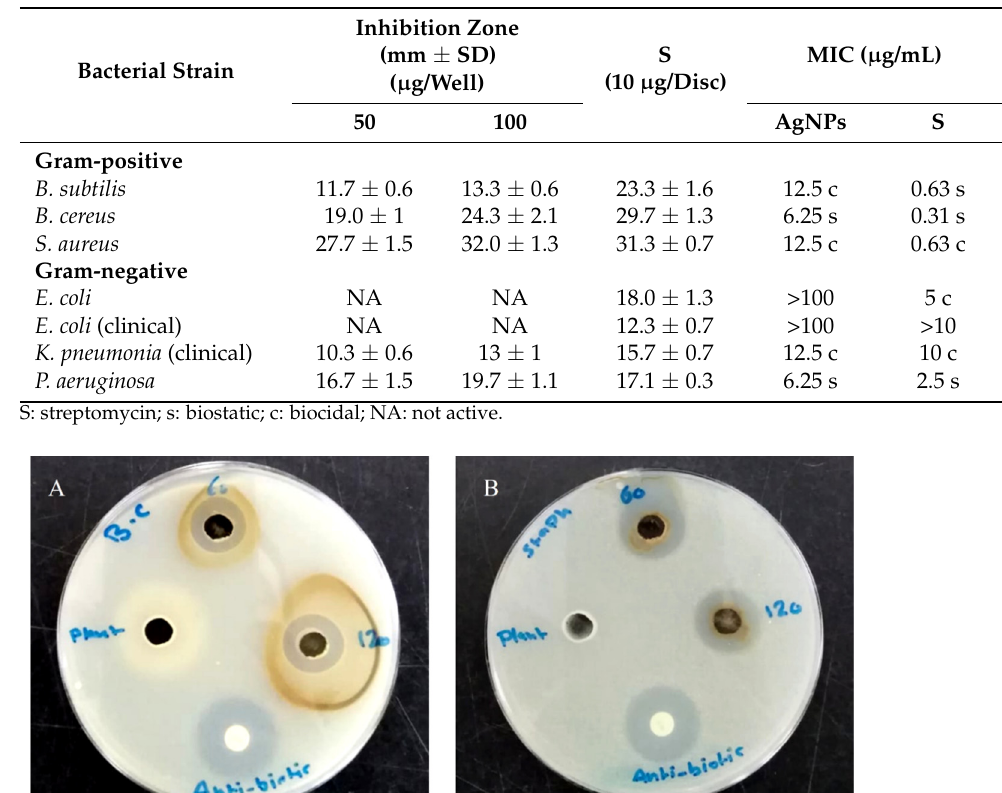
Table 1. Antibacterial activity of AgNPs and positive control against tested bacterial strains.